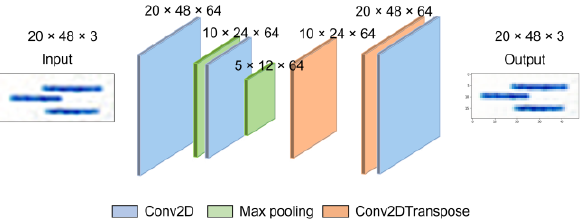
Figure 4. Architecture of the autoencoder. The output shape of each layer is also